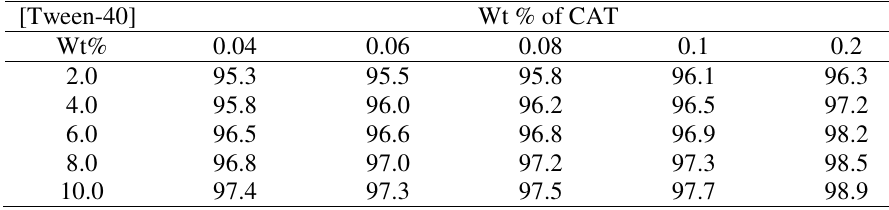
Table 3. Influence of CAT on CP of Tween-40